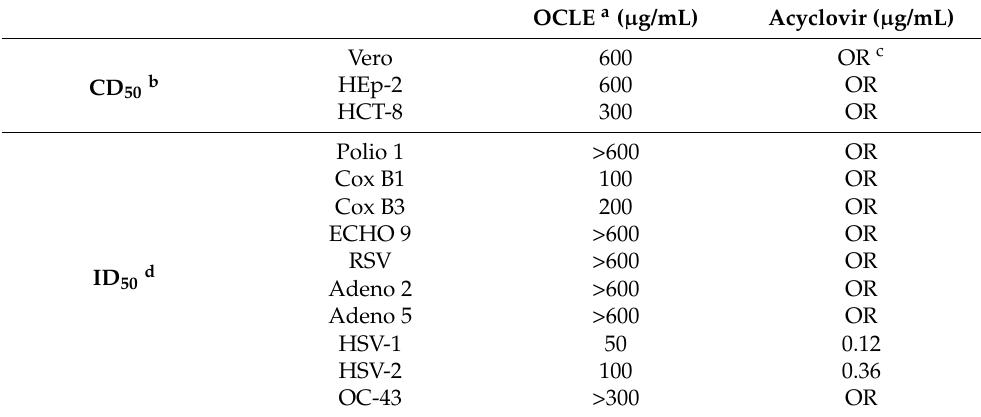
Table 1. Antiviral activity of OCLE and